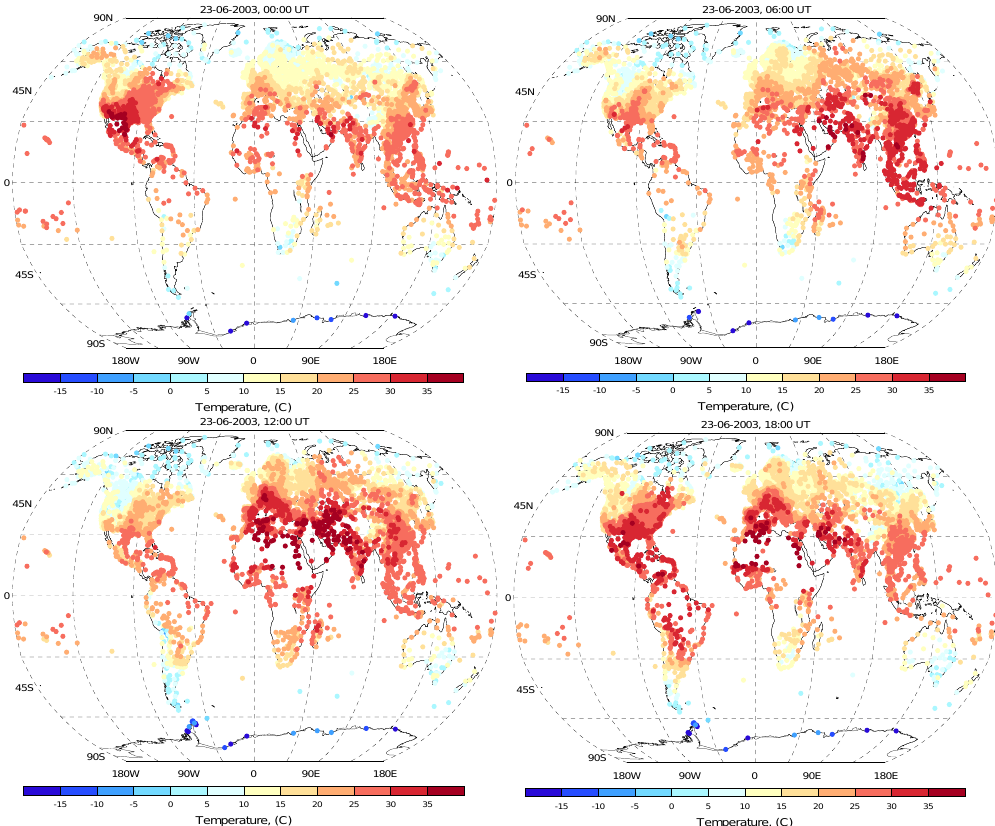
Fig. 23. The temperature for each station on the 23 June 2003 at 00:00, 06:00, 12:00 and 18:00UT using all 6103 stations.